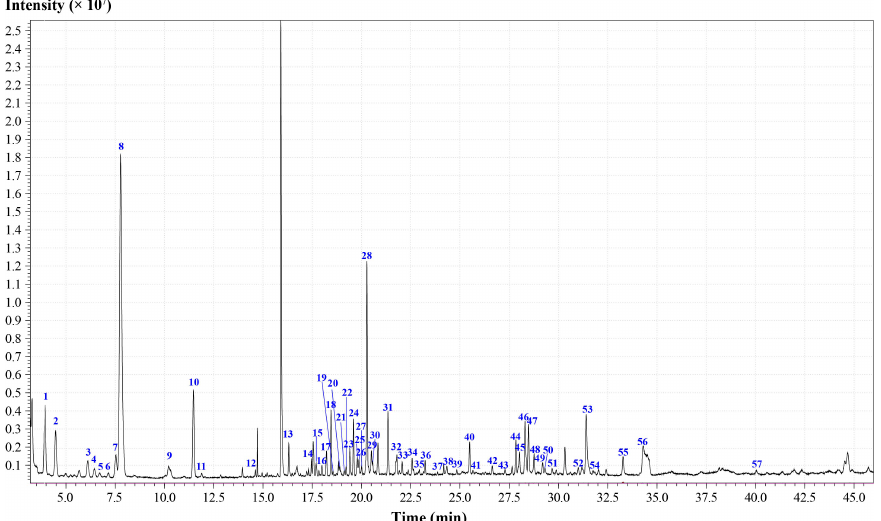
Figure 1. GC-MS total ion chromatograph of Oleum Cinnamomi . Note: The compounds represented by the numbers were consistent with those in Table 1.